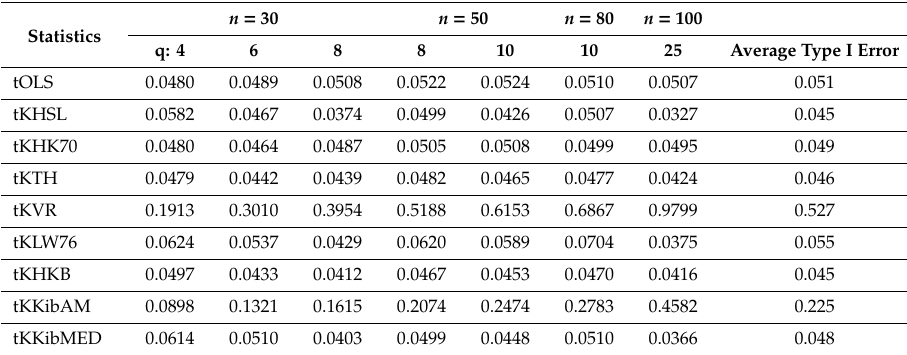
Table 3. Simulated Type I errors for ρ = 0.95 and α =